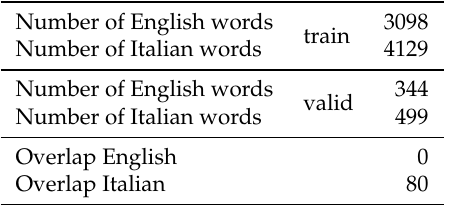
Table 4. Statistics of the new train and validation split of Dinu’s